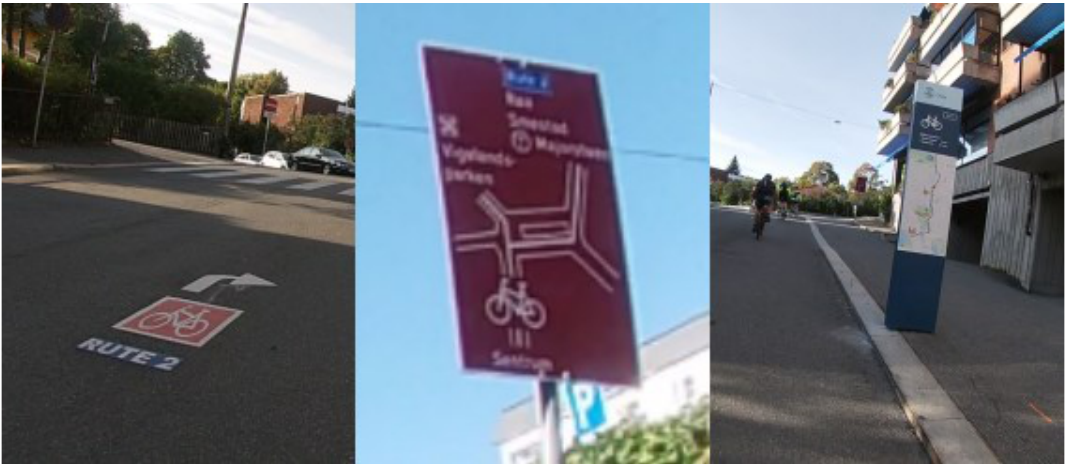
Figure 1 Examples of elements used for the new signage systems: road marking, with arrow and route identity; intersection sign; street